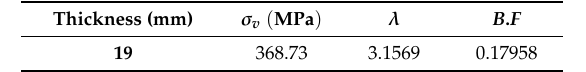
Table 3. The results of parametric analysis of the spherical submersible steel hull.